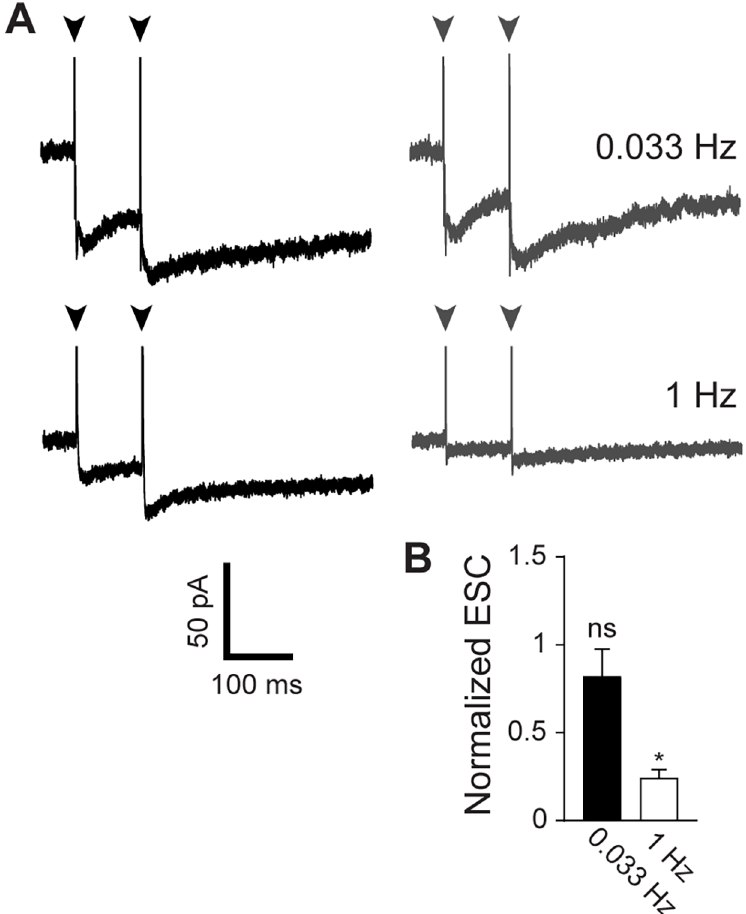
Fig 2. Depression of ectopic transmission. A) Extrasynaptic currents (ESC) recorded from Bergmann glia after paired pulse stimulation (arrows, 100 ms interval). Black traces show average of first three stimuli at 0.033 Hz (top traces) or 1 Hz (bottom traces). Grey traces show average of last three stimuli after 10 min continuous stimulation at the indicated frequencies. Stimulus artefacts have been truncated for clarity. B ) Aggregate data (n = 9 cells for each frequency) for amplitude of extrasynaptic current after stimulation at 0.033 Hz (black) or 1 Hz (white) for 10 min, normalized to the amplitude of the first ESC. (cid:3) p < 0.0001, single sample t test.